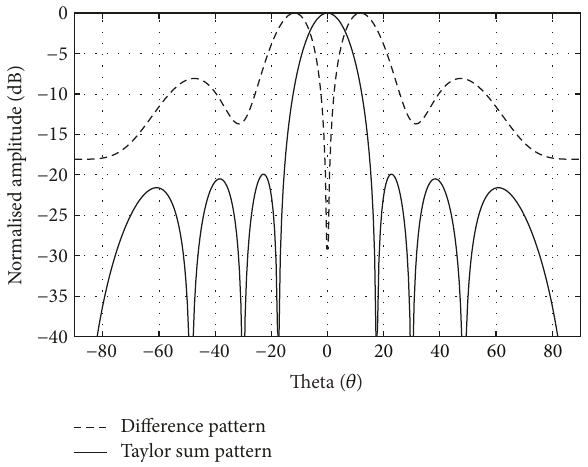
Figure 7: Taylor sum pattern for n = 6 and SLL = − 20dB, with corresponding difference